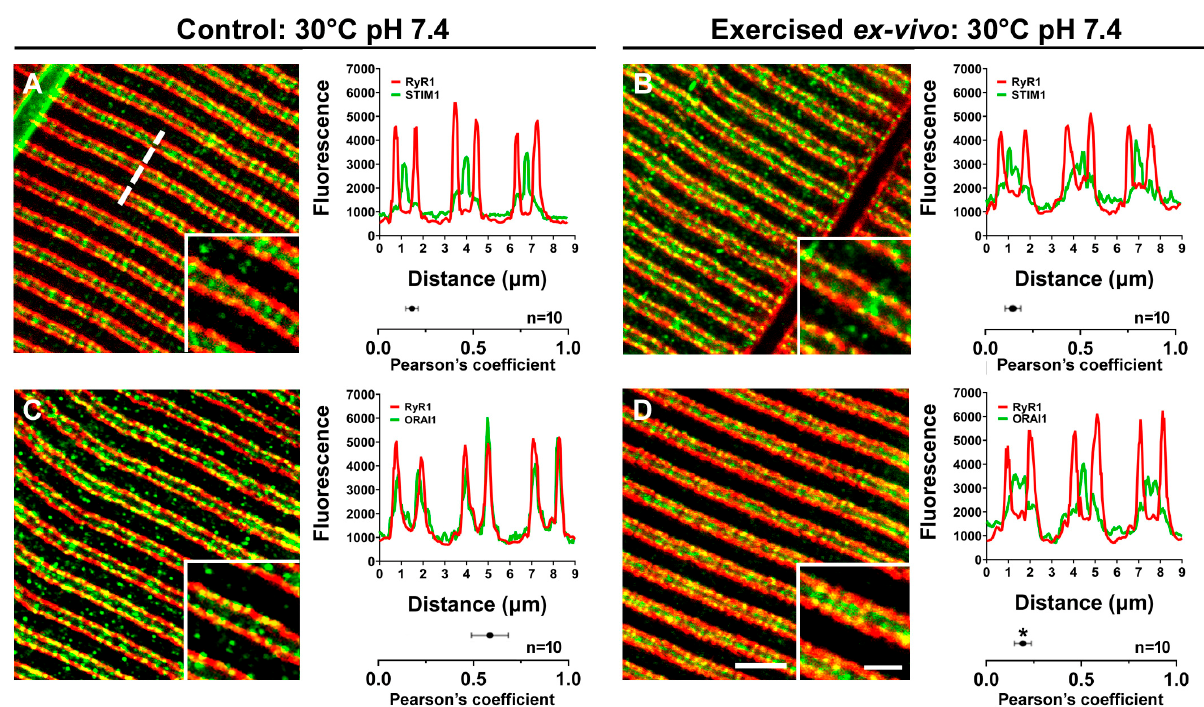
Figure 2. Sarcomeric localization of STIM1 and Orai1 before and after an ex vivo protocol per- formed at 30 °C and pH 7.4. Representative immunofluorescence images of EDL fibers showing RyR1 and STIM1 ( A , B ) and RyR1-Orai1 ( C , D ) double-staining. Each panel contains also a fluores- cence intensity profile along threesarcomeres (see dashed line in ( A )) and the Pearson’s correlation coefficient value, i.e., a method of measuring the covariance of pixel intensities, given as the mean ± SEM. * p < 0.01, compared to fibers from control mice; n = number of images analyzed. Scale bar: 2.5µm (insets: 1µm).